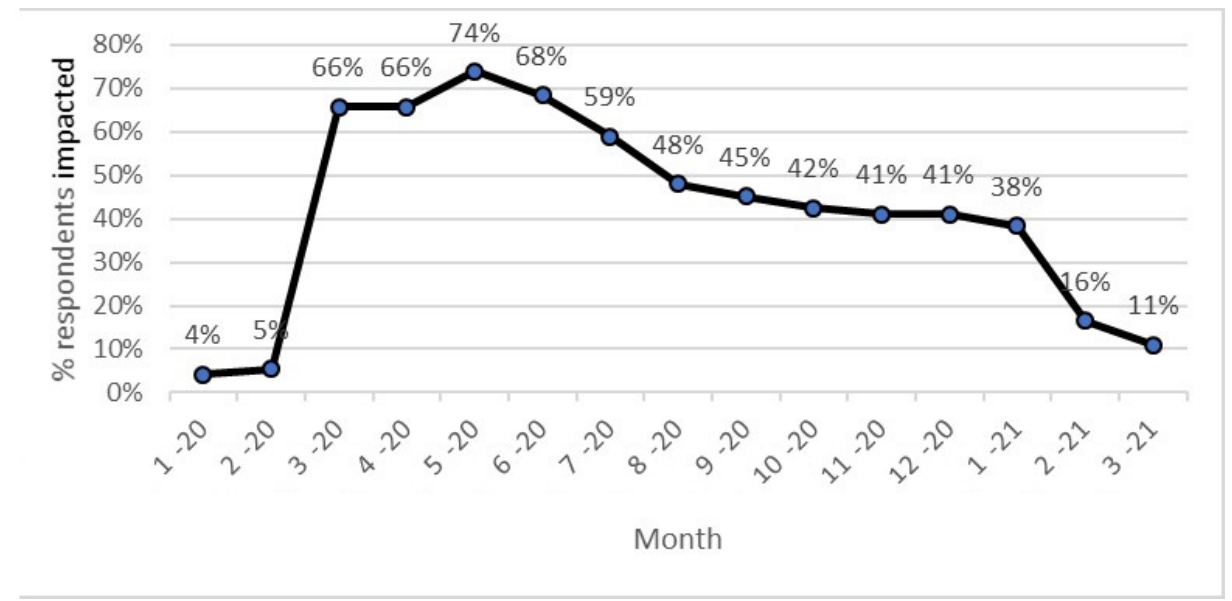
Figure 3. Months of COVID-19 impact.